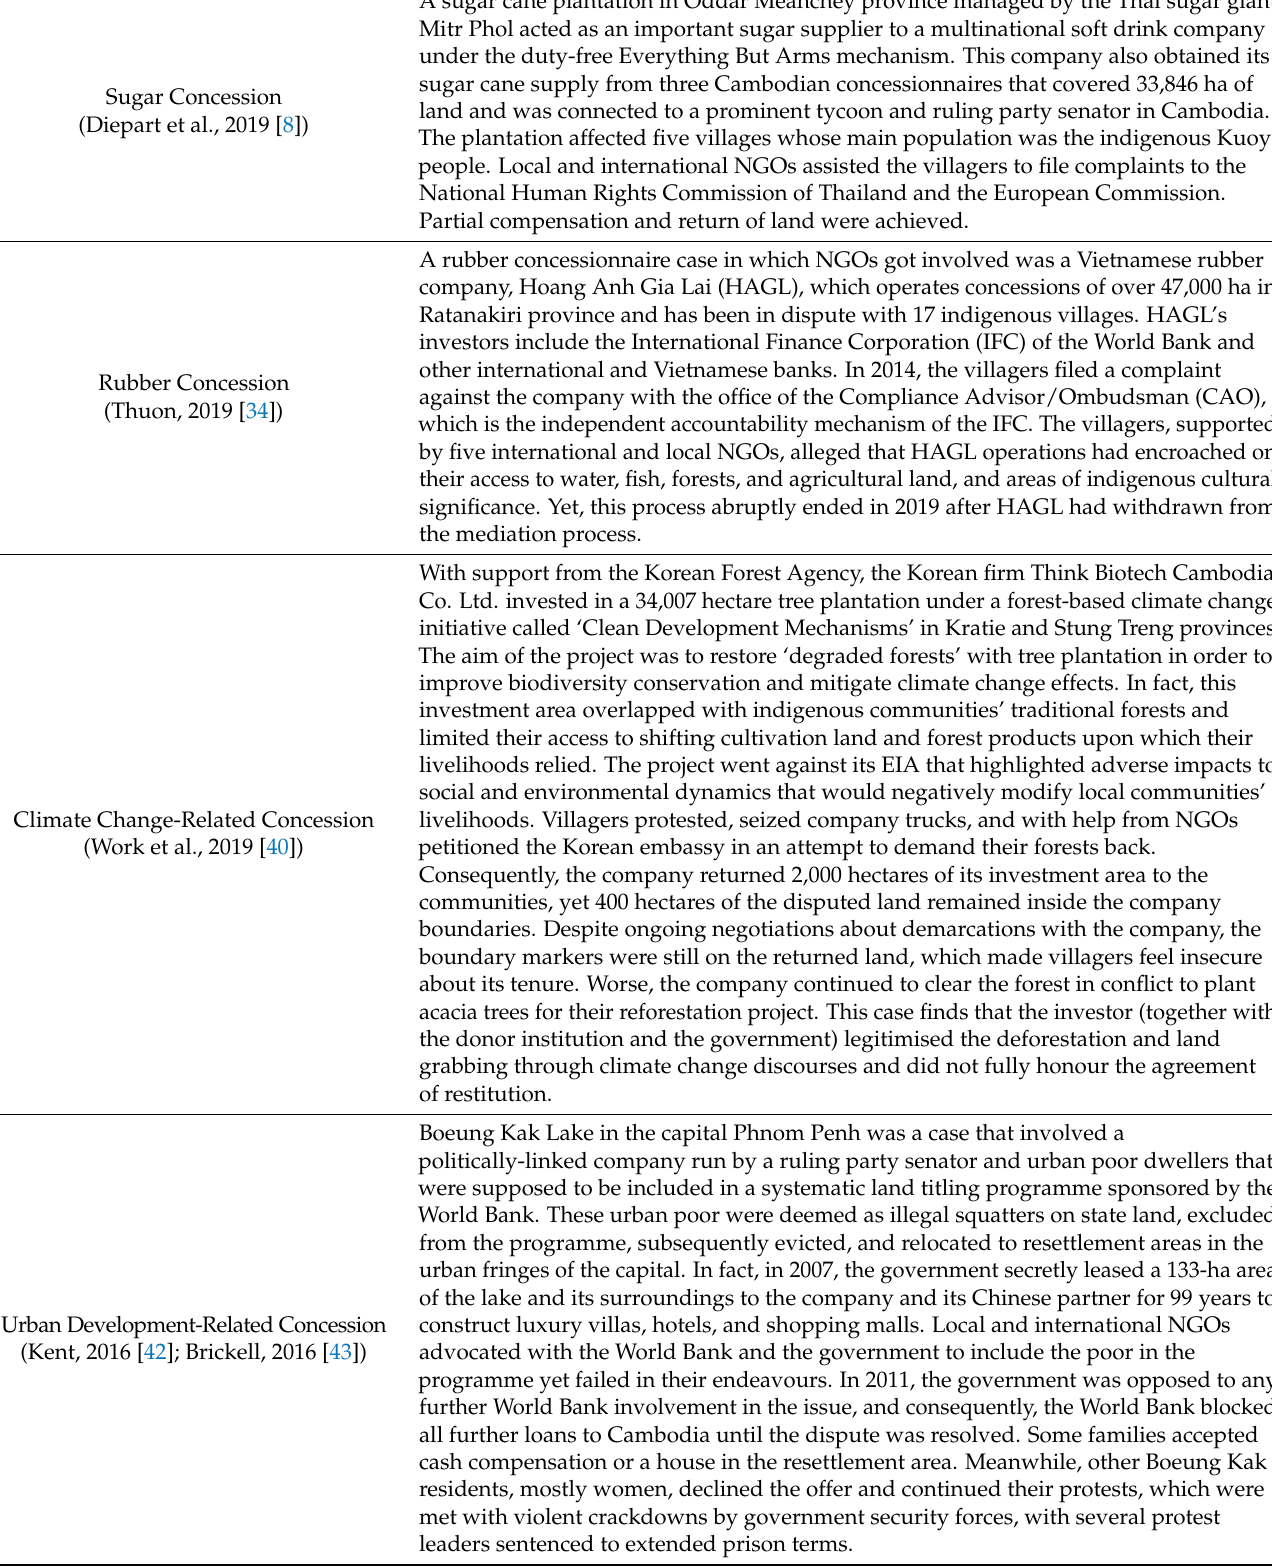
Table 1. Examples of cases with involvement from